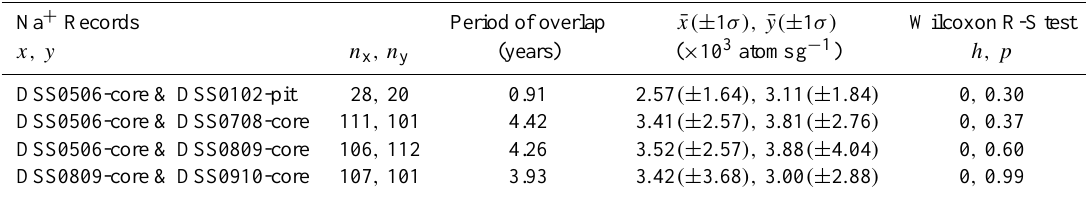
Table 3. Inter-comparison of contemporaneous sections of Na + records from the same ice cores and snow pits used in the analysis of 10 Be reproducibility. As in Table 2, a Wilcoxon rank-sum hypothesis test is used to test the null hypothesis that the two series are independent samples from identical continuous distributions with equal medians ( h = 1 implies that the null hypothesis should be rejected as p < 0 . 05). Note that trace chemistry was not measured on the